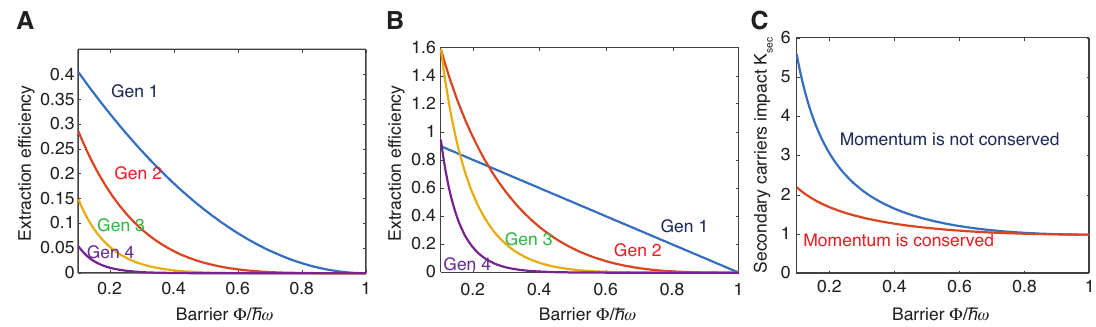
Figure 11: Relative extraction efficiency of the primary and secondary generations of non-equilibrium carriers of different generations as a function of barrier